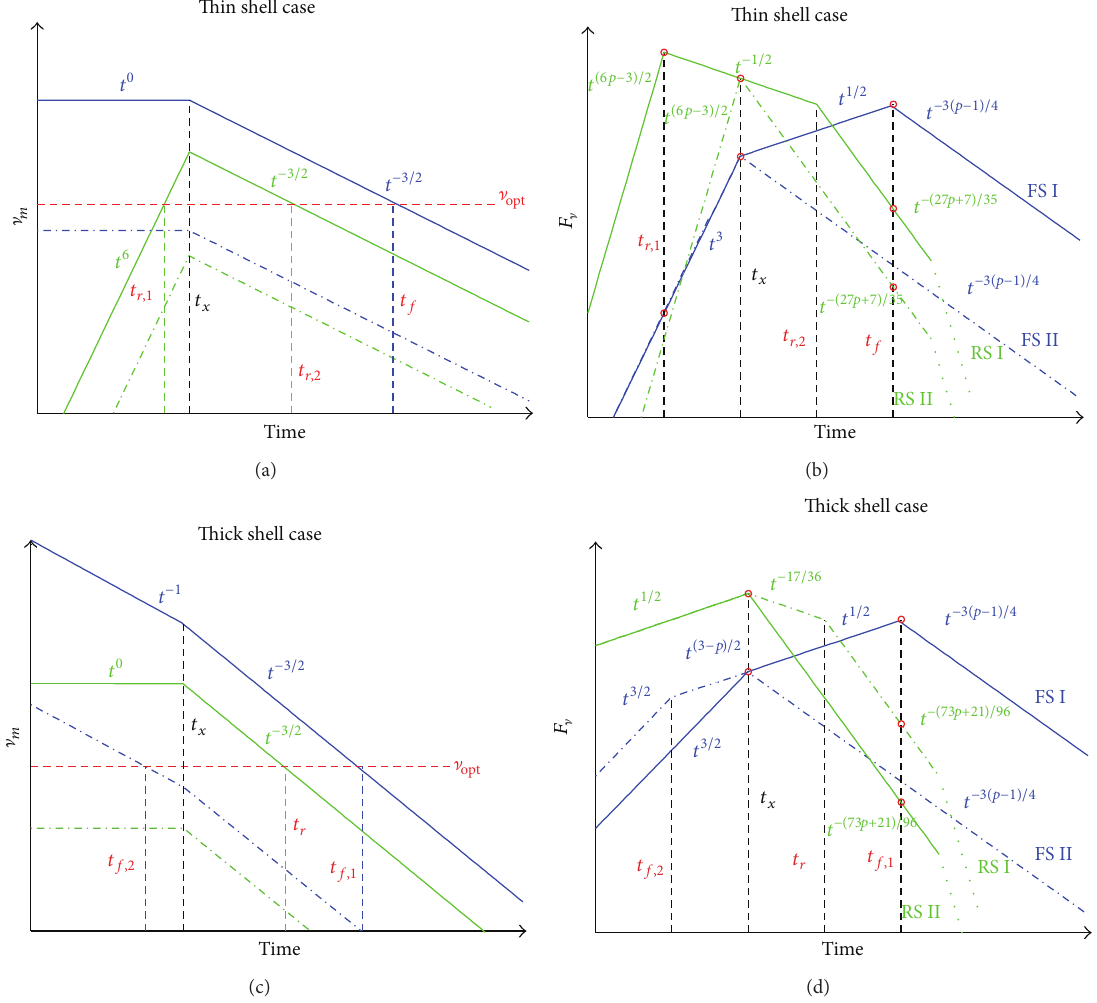
Figure 1: Illustration of the ] 𝑚 evolution ((a), (c)) and optical lightcurves ((b), (d)) for both forward shock (blue lines) and reverse shock (green lines) emission, from [91]. Red circles on lightcurve indicate the points for comparison in order to categorize the lightcurve types [91].